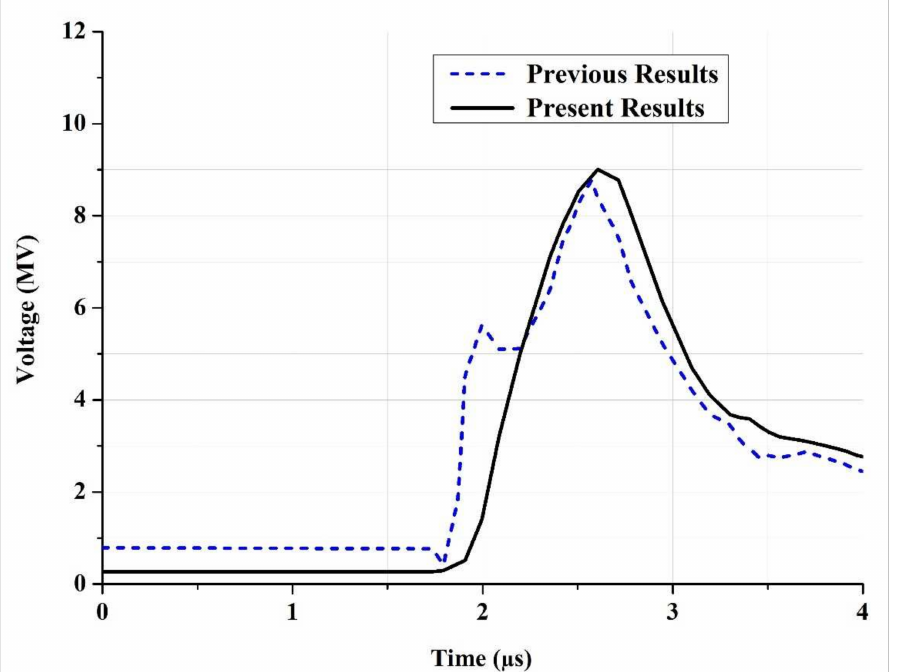
Figure 10. Comparison between the voltage across insulator in the present and previous results [15] while applying the strike at tower top using the same tower